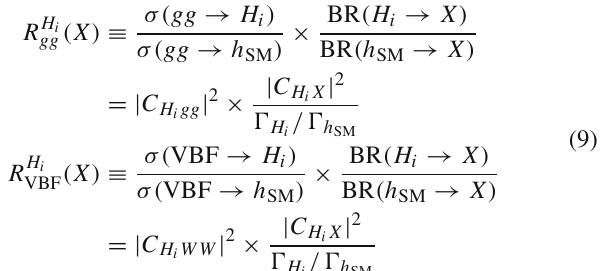
Fig. 2 Samples projected on λ − κ plane, λ − A t plane and μ − tan β plane. The green color indicates samples excluded by the DM direct detection experiments, and the red ones are still experimentally